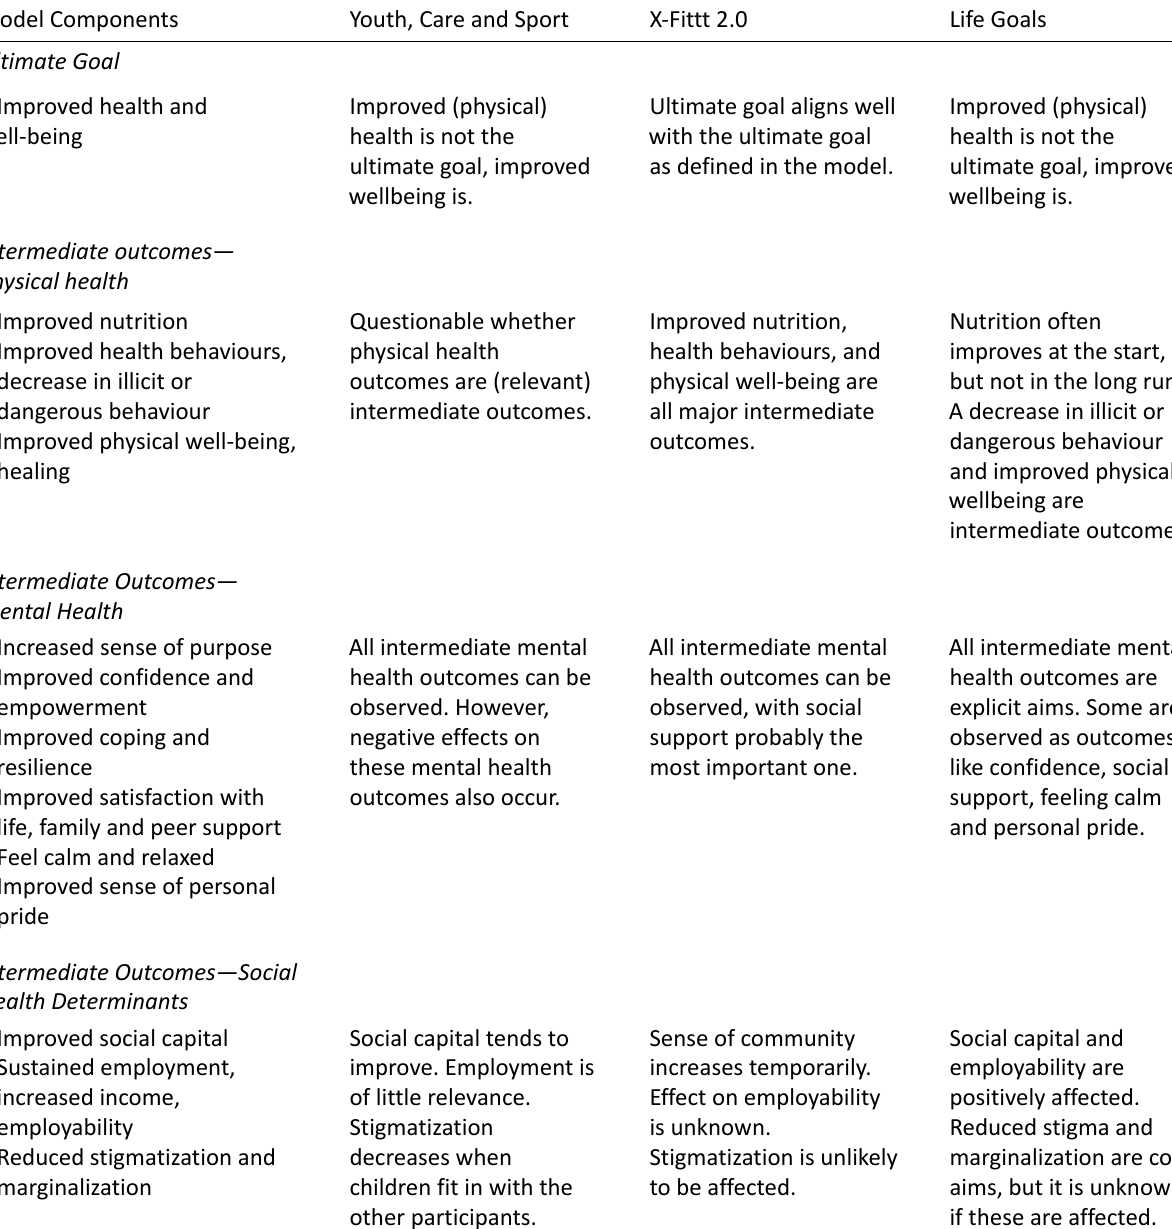
Table 1. Respondents’ reflections on the applicability of the model by Roy et al. (2017) to ‘their’ SfD